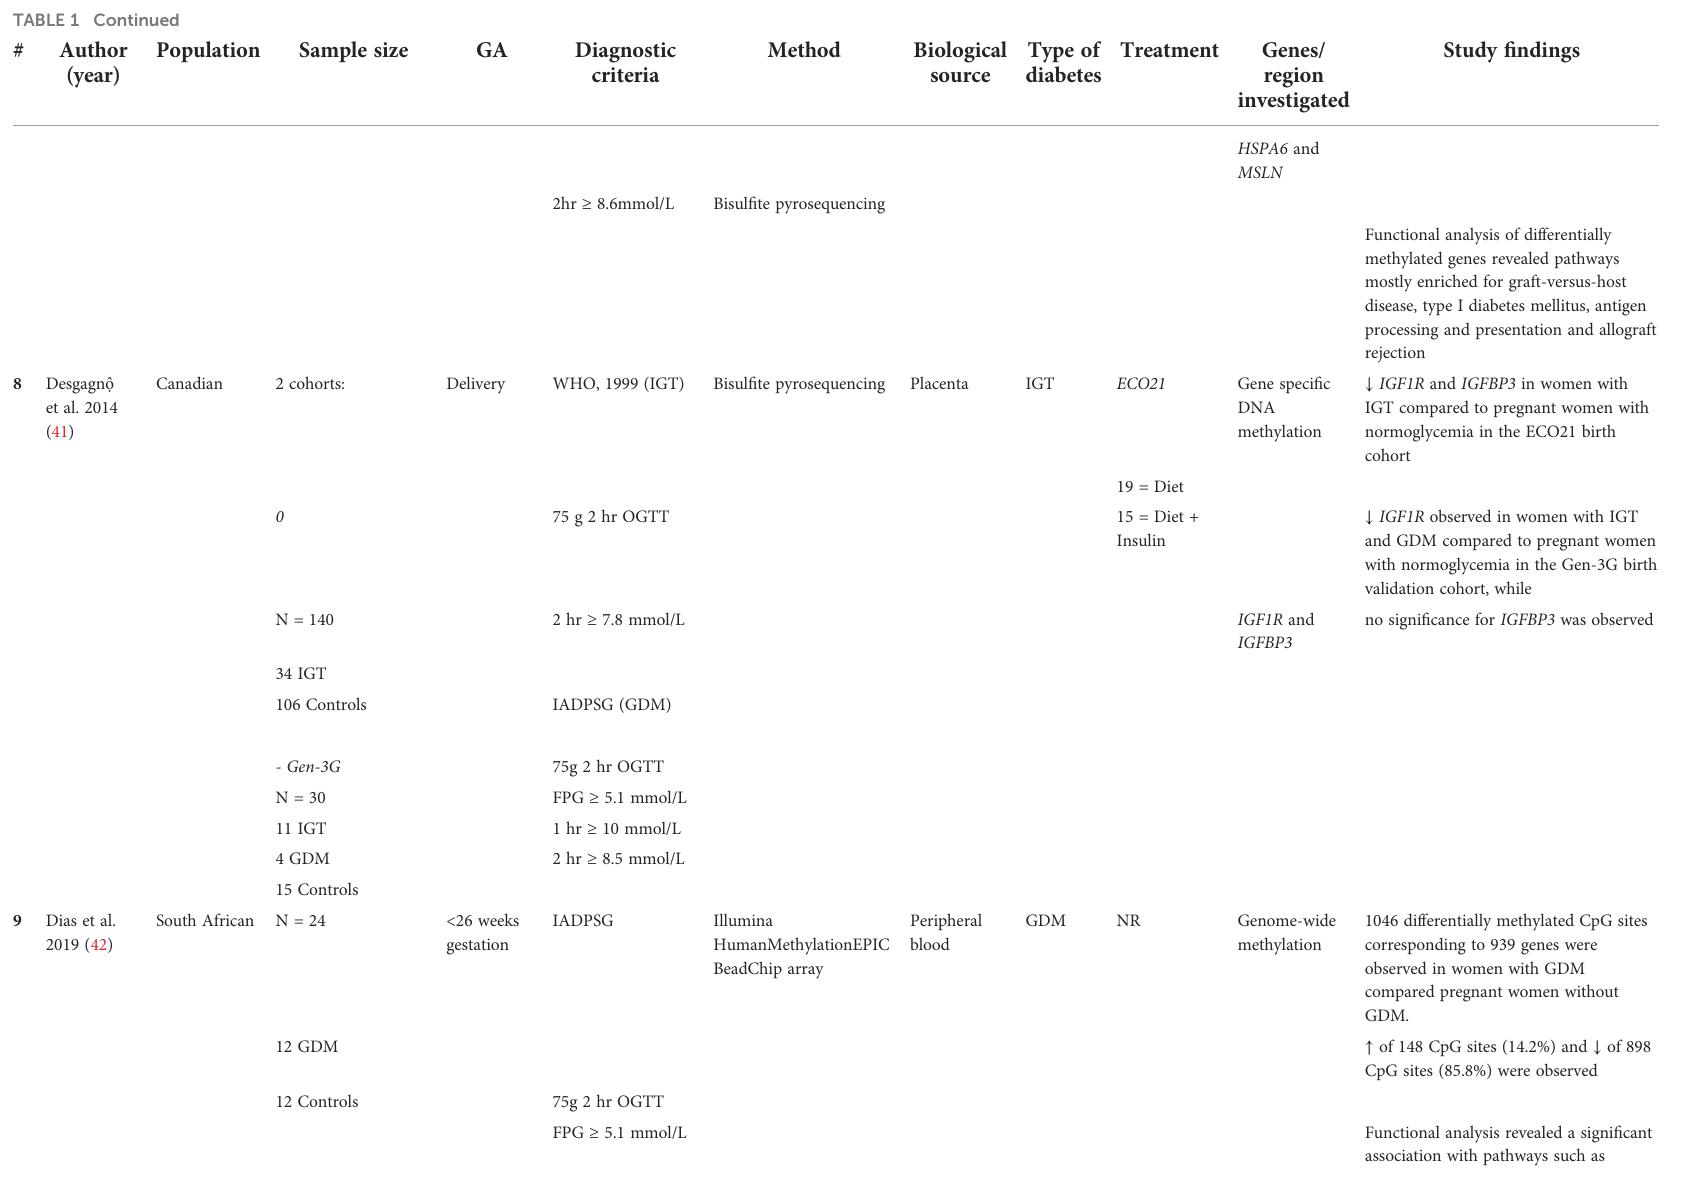
Functional analysis revealed a signi fi cant association with pathways such